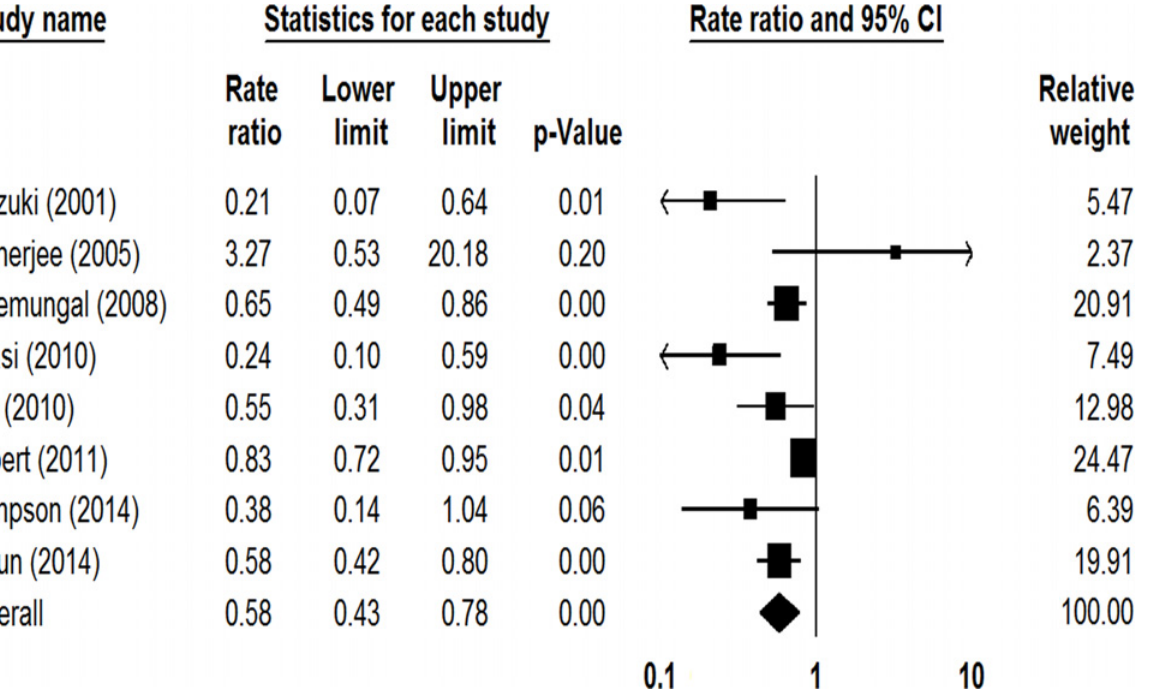
PLOS ONE | DOI:10.1371/journal.pone.0121257 March 26,